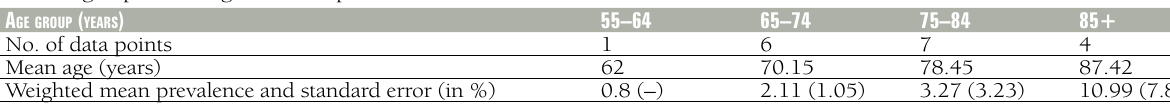
Table 5 Age–specific weighted mean prevalence (%) of Alzheimer disease in Africa